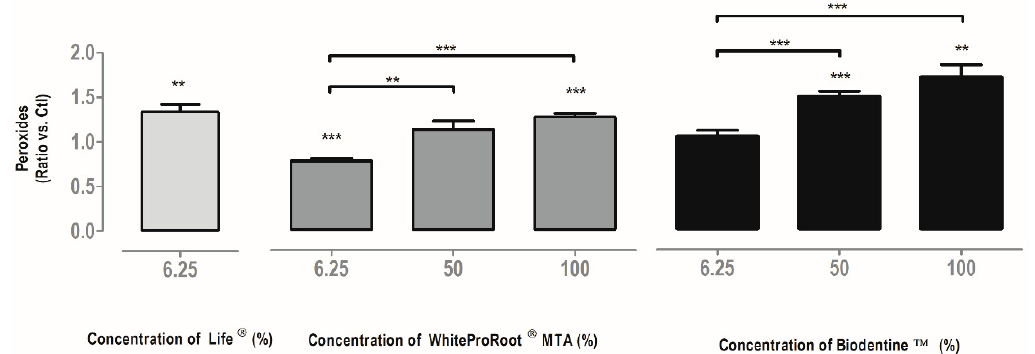
Figure 4. Intracellular peroxide production in MDPC-23 cells treated with Life ® , WhiteProRoot ® MTA and Biodentine ™ after 120 h of incubation. The results are presented as a variation against control cell cultures. All the results express the mean and standard error of at least seven independent assays. In all results, significant differences from control or between conditions are represented by *, where * means p < 0.05, ** means p < 0.01 and *** means p < 0.001.